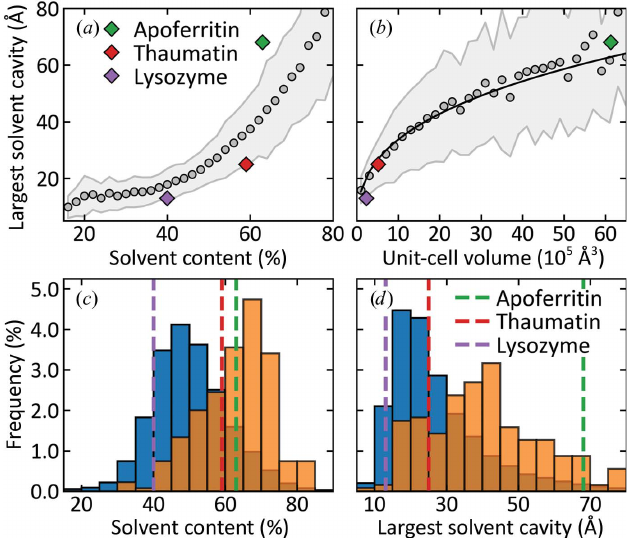
Figure 1 ( a , b ) Mean size and distribution of the largest solvent cavity within the unit cell versus solvent content and unit-cell volume obtained from 17 148 nonredundant protein structures in the PDB, excluding small peptides and viral proteins. Symbols indicate mean values and the shading indicates the region within one standard deviation of the maximum of the distribution. The solid line fitted in ( b ) has the form (cavity size) / (cell volume) 1/3 , so cavity size scales with linear unit-cell dimension. ( c , d ) Histograms of PDB entry distributions versus solvent content and largest solvent cavity for soluble proteins (blue) and membrane proteins (orange). The corresponding values for cubic apoferritin, tetragonal thaumatin and tetragonal lysozyme crystals are marked in each